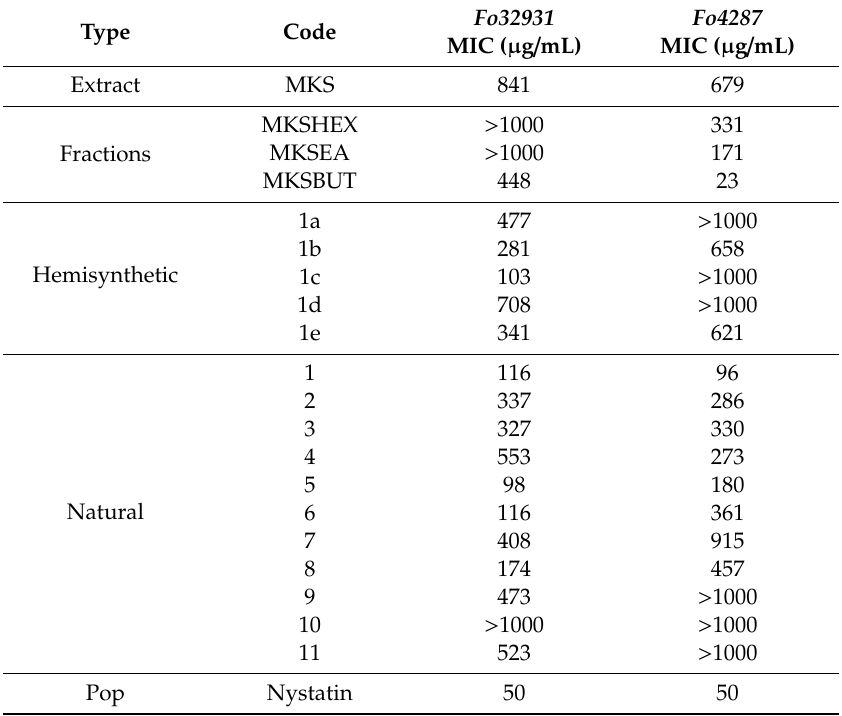
Table 1. Minimum inhibitory concentration (MIC) of crude extracts, fractions, as well as natural and hemisynthetic pure compounds against Fo32931 and Fo4287